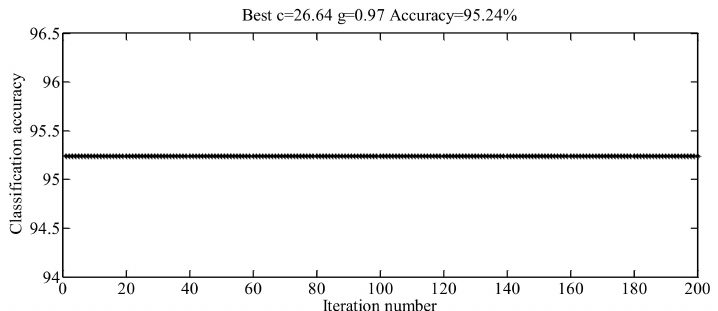
Figure 16. Parameter optimal results under the unbalanced samples condition.